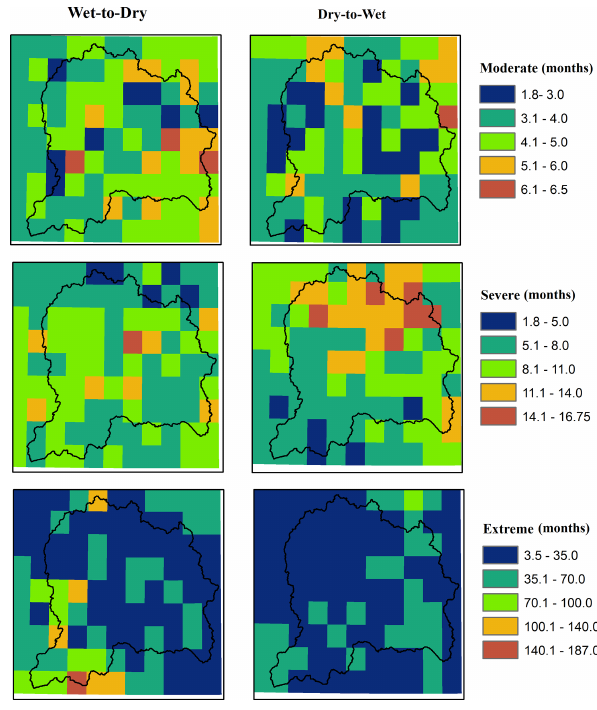
Figure 8. Number of transitions from wet-to-dry (left) and dry-to- wet (right) events for three levels of severity (moderate, severe, ex- treme) for the period 1981–2014.